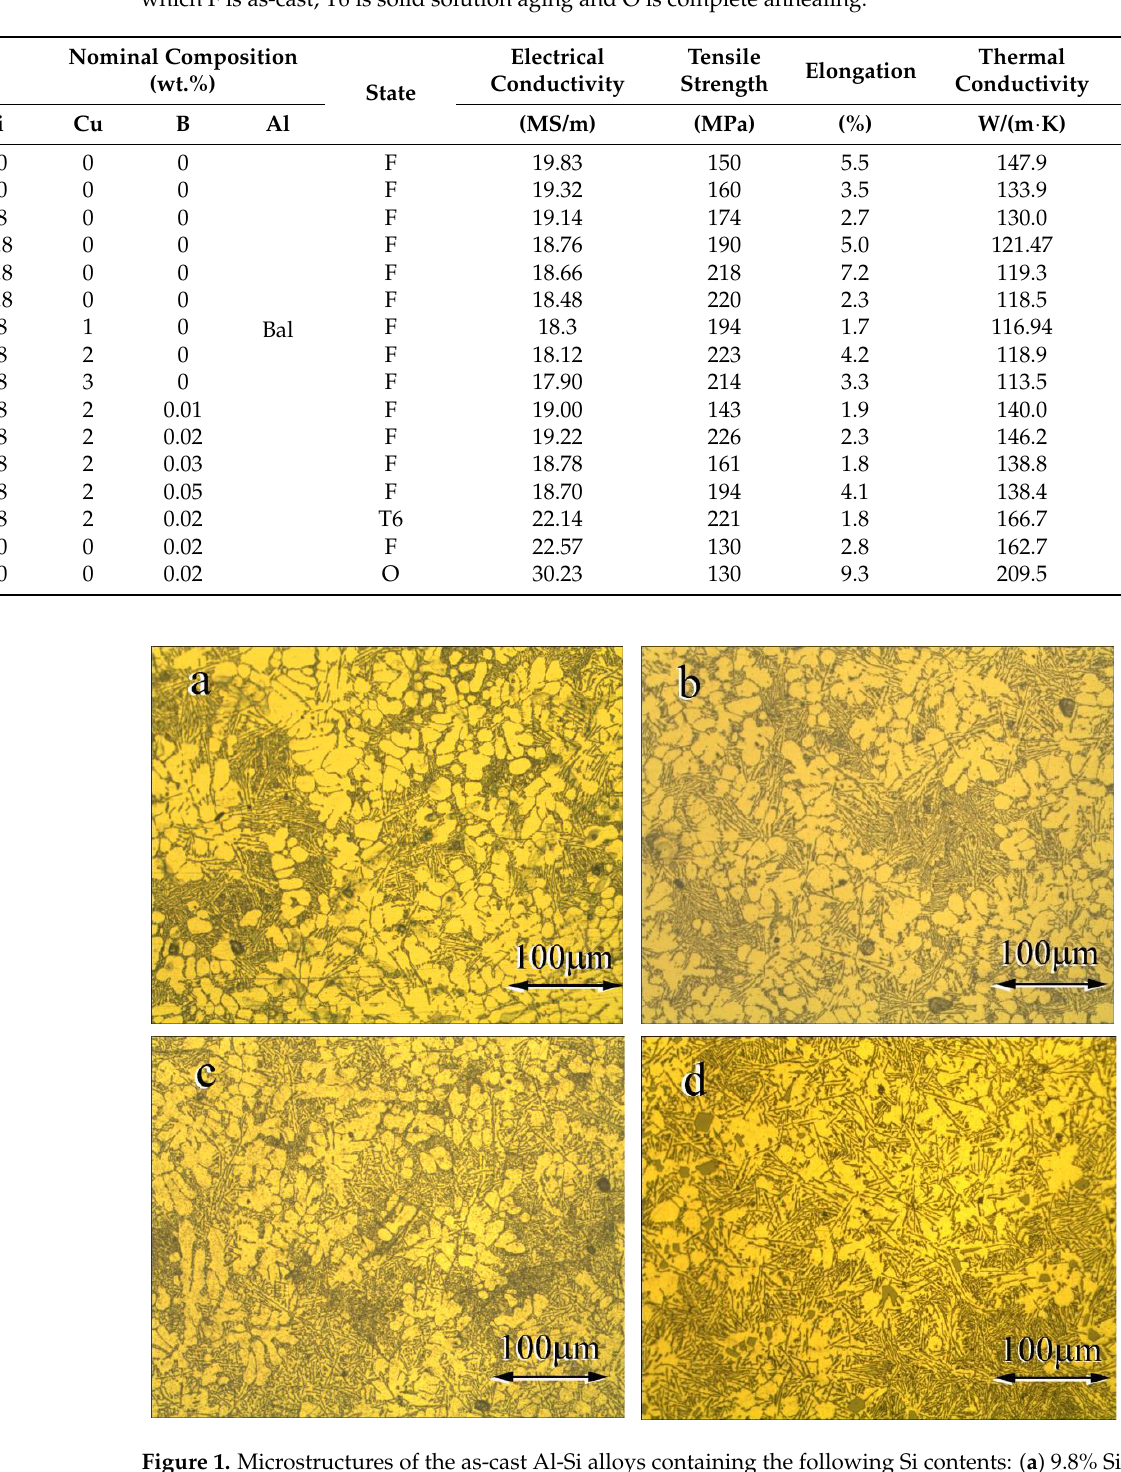
Table 3. Conductivities and mechanical properties of the specimens with different compositions, in which F is as-cast, T6 is solid solution aging and O is complete annealing.